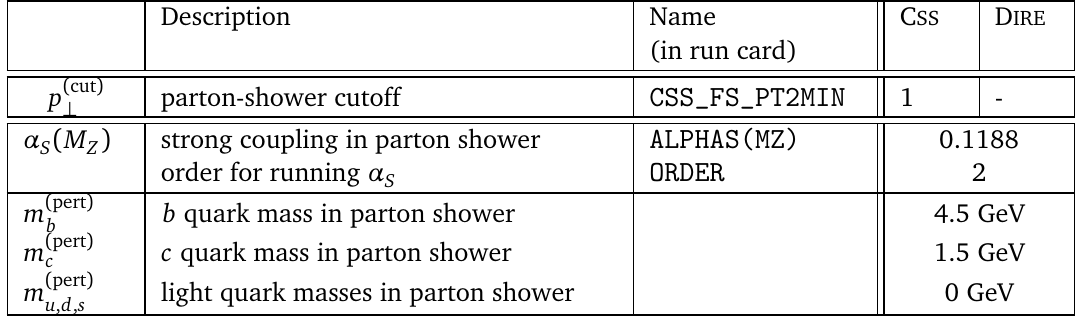
Table 2: (Fixed) perturbative input parameters for the parton showers and the tuned value for its infrared